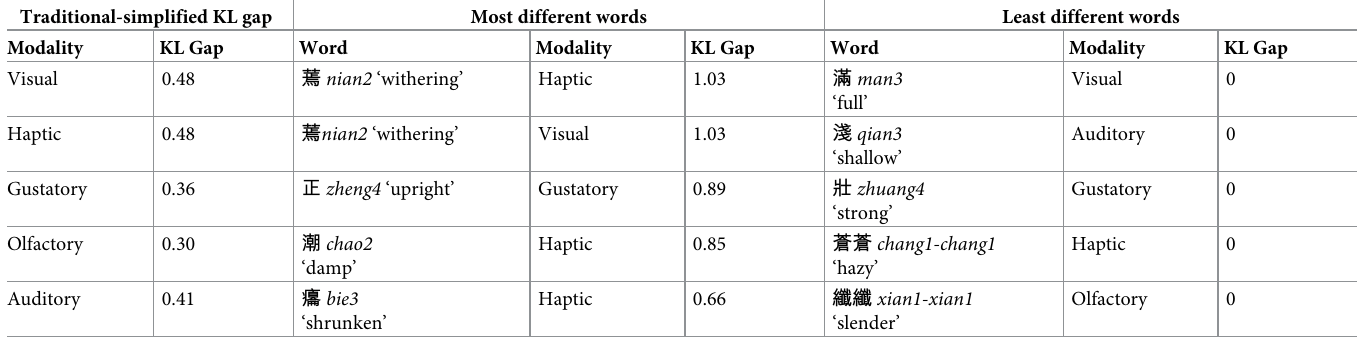
Table 4. Differences between traditional and simplified character users: The KL gap per modality and the KL gaps for words with the biggest and smallest difference. Traditional-simplified KL